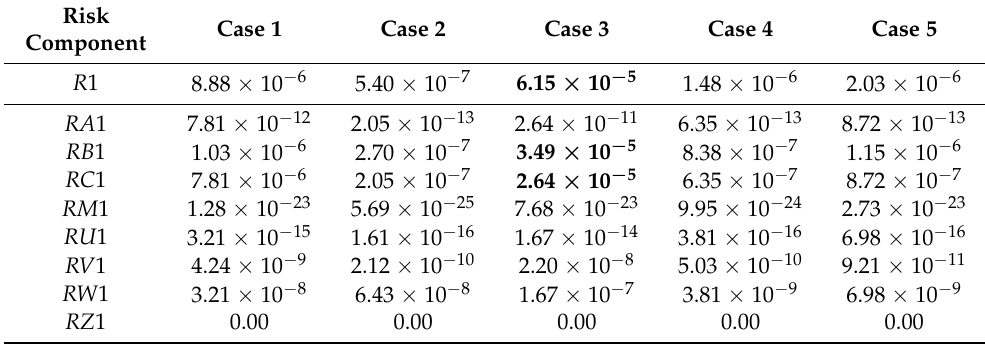
Table 18. Result of Risk Value of Loss of Human Life ( R 1) -Improved-case.